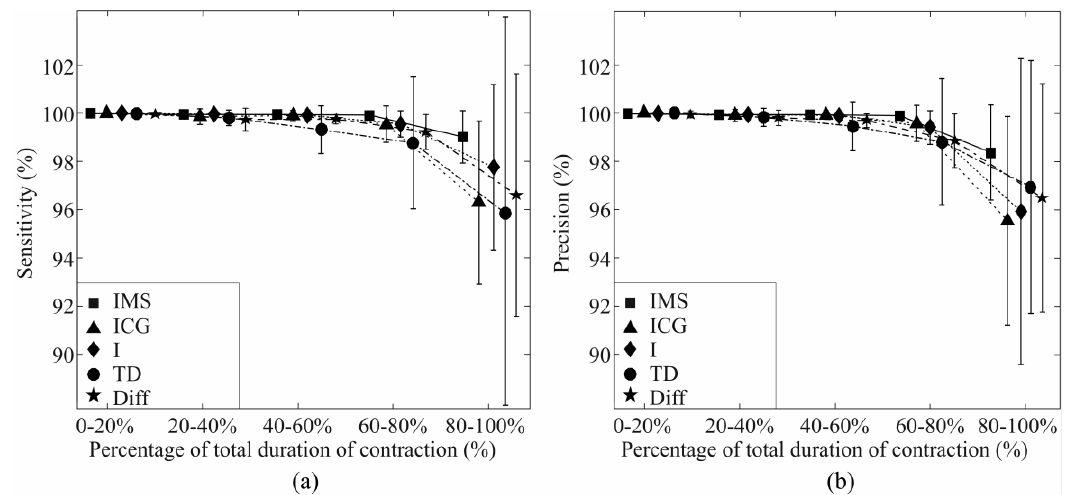
Figure 11. Influence of fatigue on ( a ) sensitivity and ( b ) precision of the identification of task using IMS, ICG, I, TD, and Diff features. IMS, ICG, I, TD, and Diff